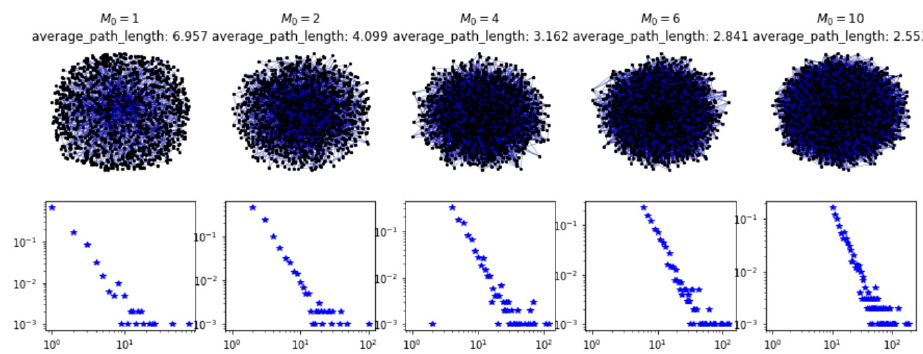
Figure 6. Evolution of the FSN under different node degrees M 0 .